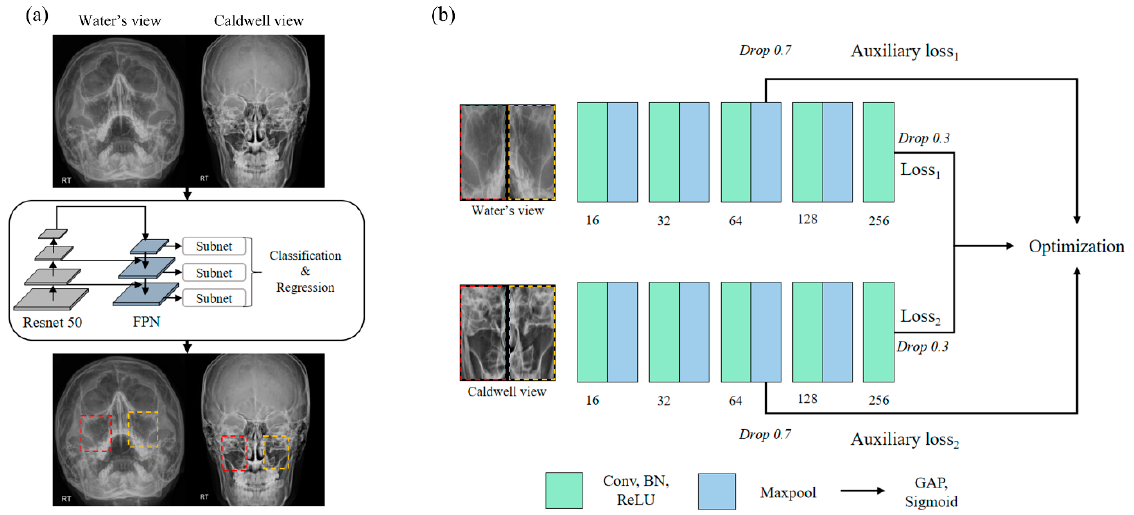
Figure 1. ( a ) Displays the overview of the framework to detect paranasal sinusitis using RetinaNet. Red and orange bounding boxes indicate the region of left and right sinuses, respectively. ( b ) provides the schematic diagram of Aux-MVNet that represents the roles of the individual blocks. Abbreviations: FPN, feature pyramid network; Drop, drop out; BN, batch normalization; ReLU, rectified linear unit; GAP, global average pooling.